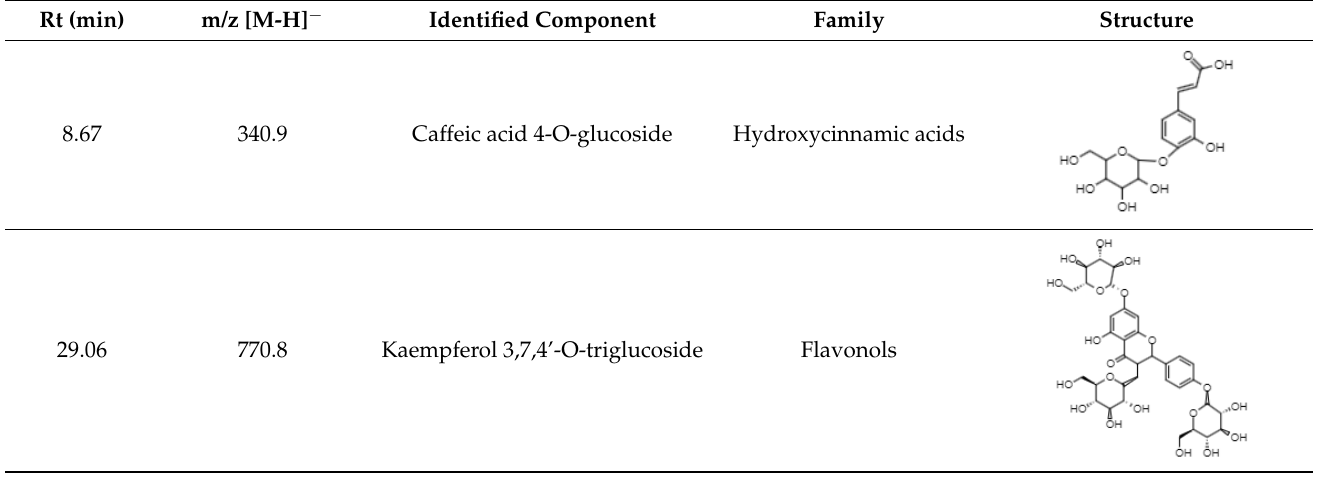
Table 3. Components identified by reverse-phase high-performance liquid chromatography (RP- HPLC-ESI-MS) in the extract of E. hyemale . Rt, retention time; m/z, mass-to-charge ratio; min, minutes.